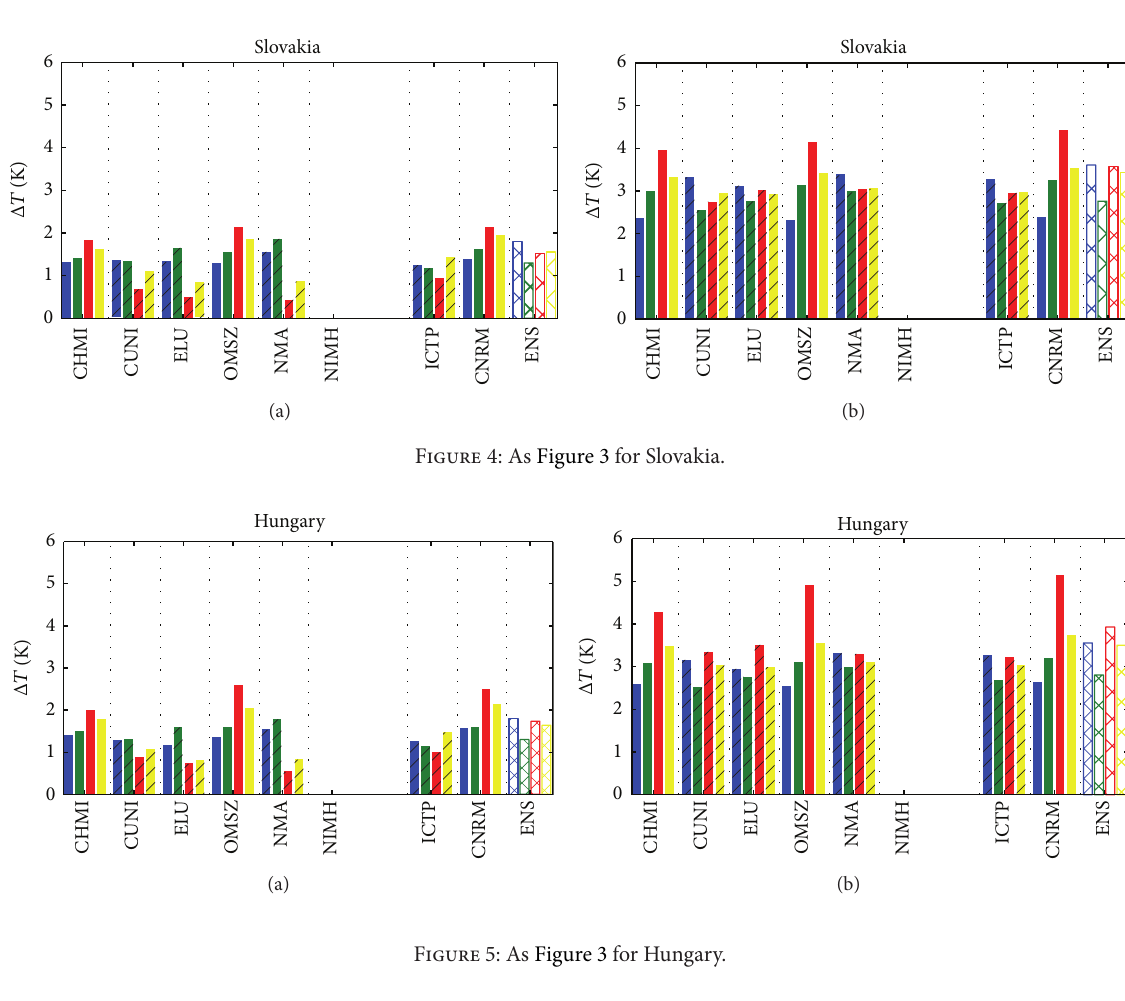
Figure 3: Change in 2m temperature over Czech Republic between 2021–2050 and 1961–1990 (a) and 2071–2100 and 1961–1990 (b); blue = DJF, green = MAM, red = JJA, yellow = SON, hatched = RegCM-ECHAM couple, plain = Aladin-Arpege couple, and ENS = average of 14 ENSEMBLES models.